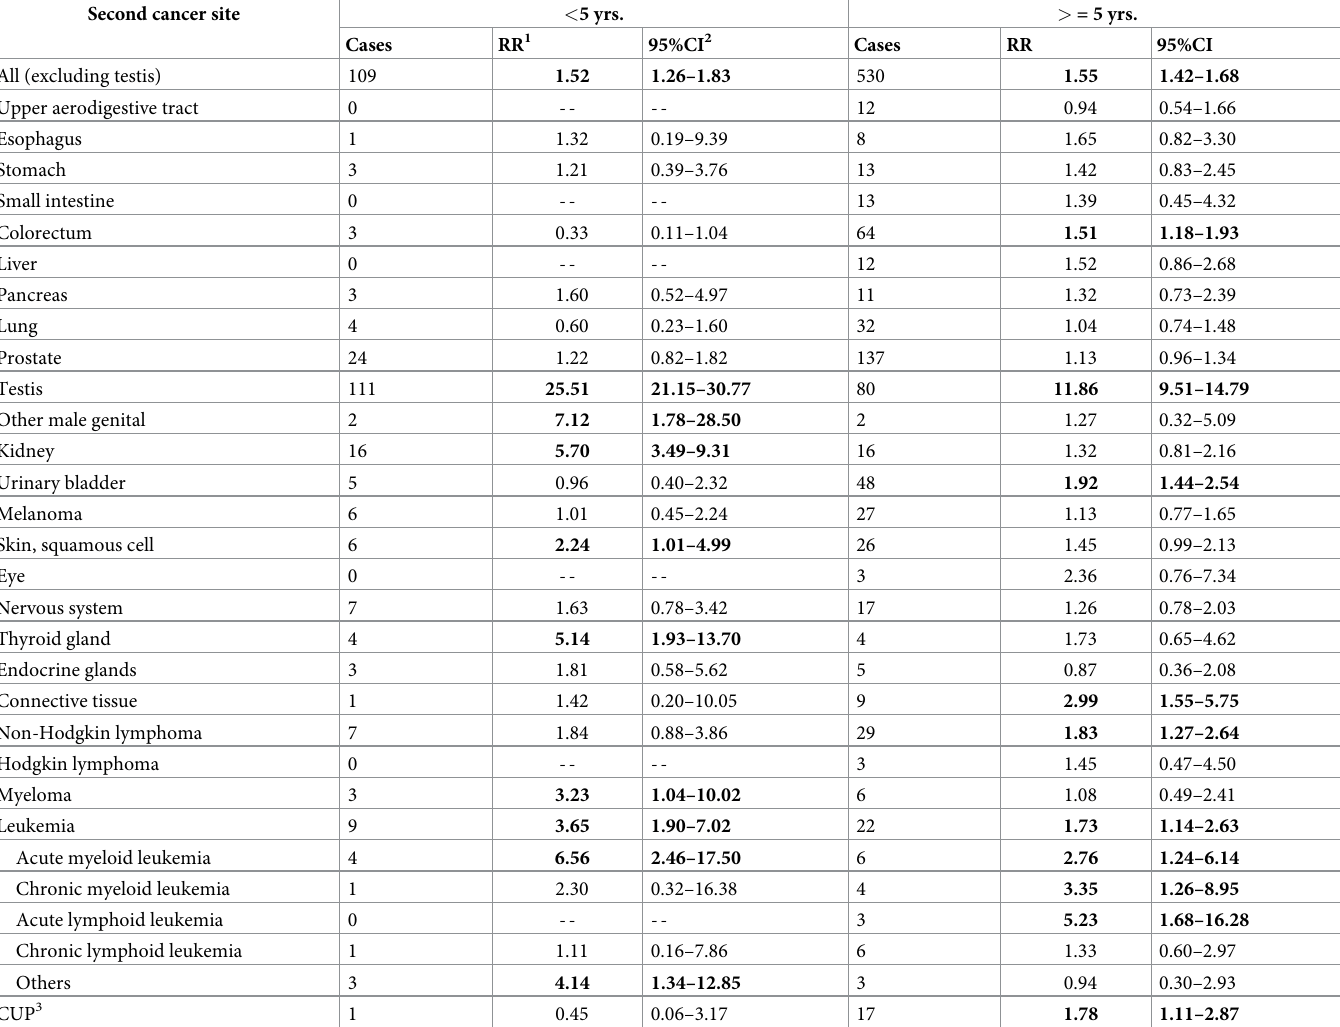
Table 3. Relative risks (RRs) of second primary cancers in survivors of testicular cancer by follow-up time. Second cancer site < 5